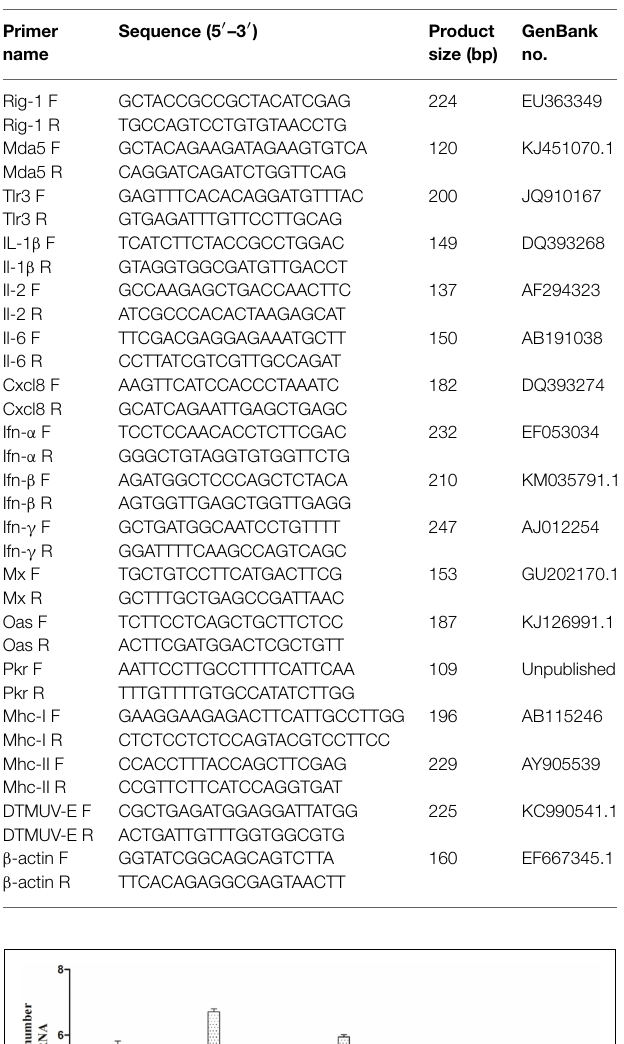
TABLE 1 | Primers used in this study.